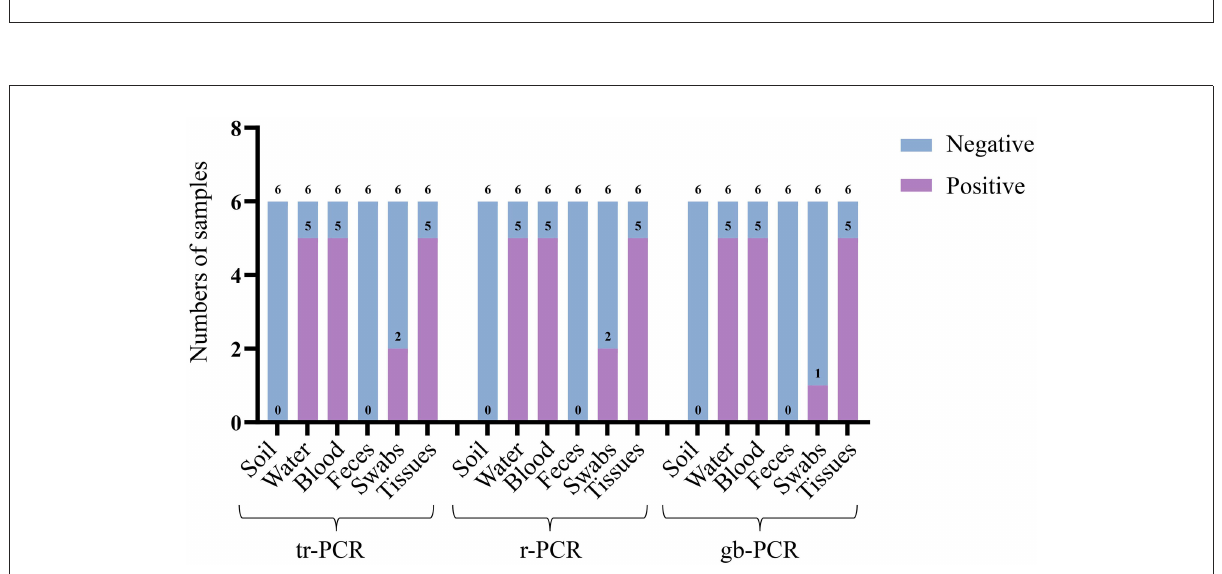
FIGURE5 Detection of different real-time PCR methods on different laboratory sample